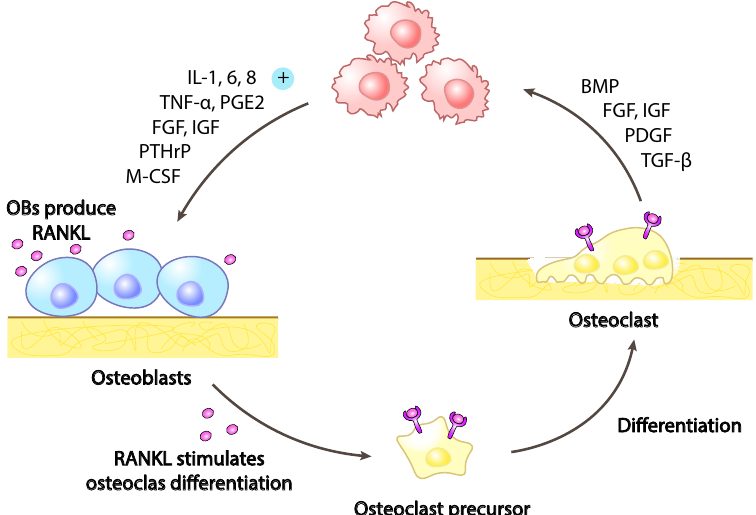
Figure 3. Vicious cycle of osteolytic metastases. Tumoural cells secrete soluble factors as interleukines (IL), tumour-necrosis factor alpha (TNF- α ) and parathyroid-hormone related peptide (PTHrP), pro- moting osteoblasts mediated receptor activator of nuclear factor kappa-B ligand (RANKL) secretion. RANKL stimulates pre-osteoclasts differentiation into fully mature osteoclasts increasing therefore the bone matrix degradation and the release of the soluble factors trapped in it, like transforming-growth factor beta (TGF- β ), bone morphogenic protein (BMP), fibroblasts growth factor (FGF), insuline-like growth factor (IGF) and platelet-derived growth factor (PDGF). Finally, these growth factors stimulate tumoural growth resulting therefore in a feed forward vicious